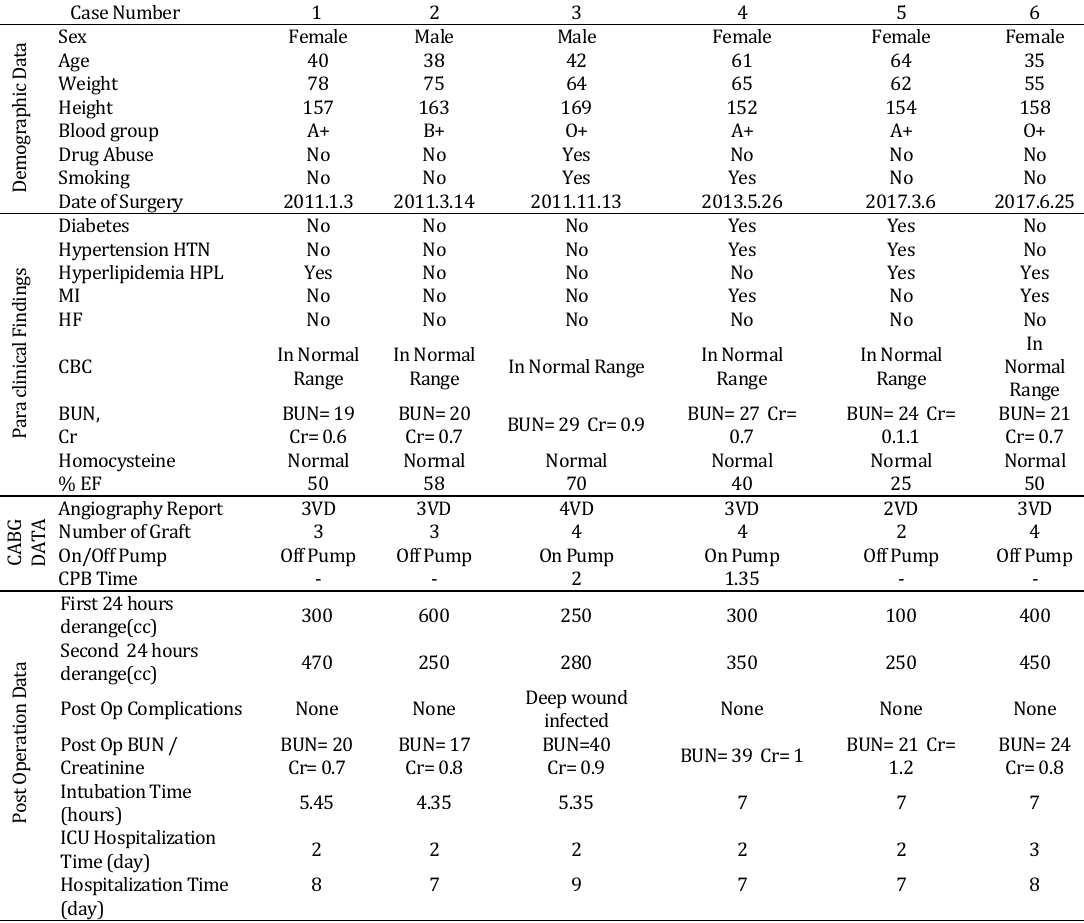
Table1 : demographic, clinical and surgical data Case Number